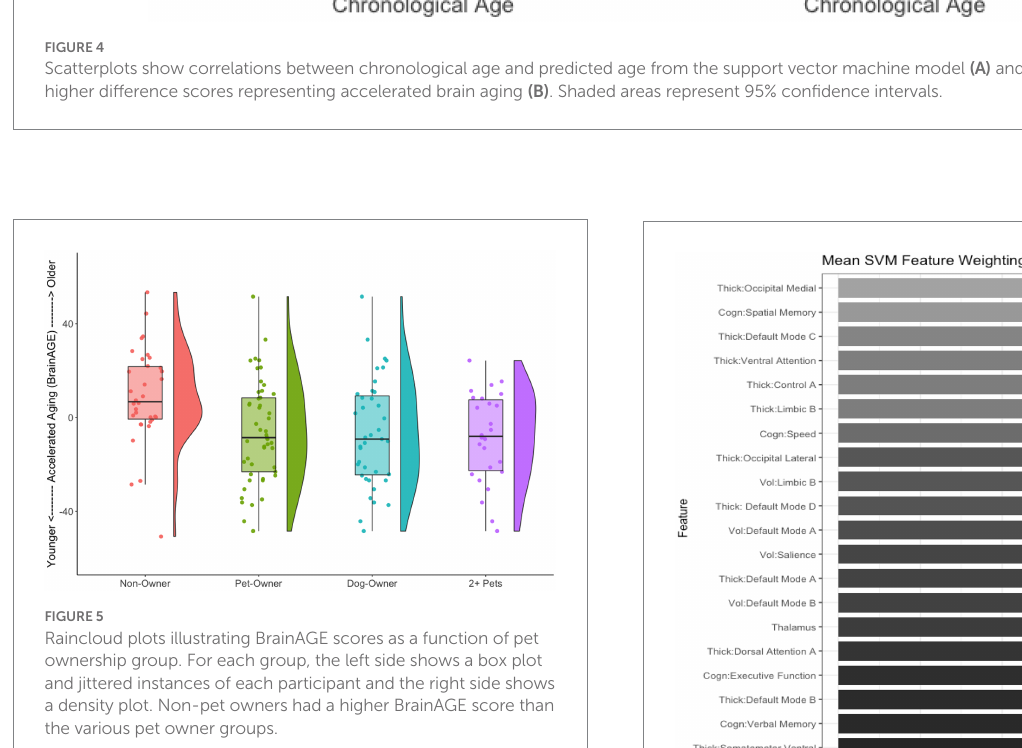
a density plot. Non-pet owners had a higher BrainAGE score than the various pet owner